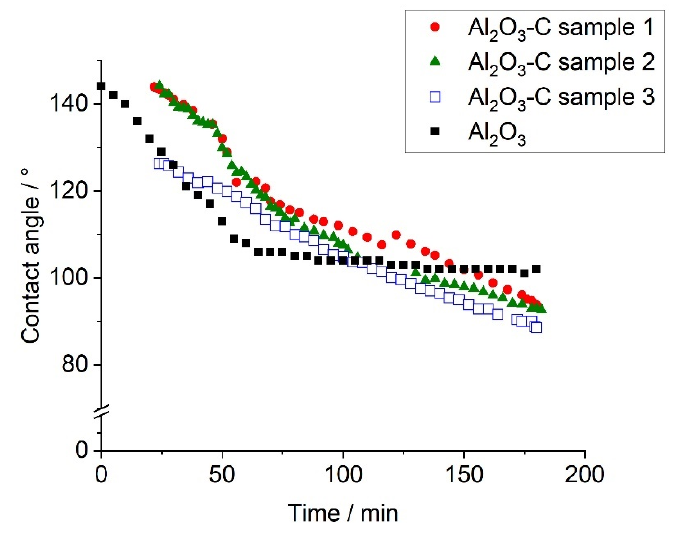
Figure 2. Time dependency of the contact angle determined by sessile drop measurement .